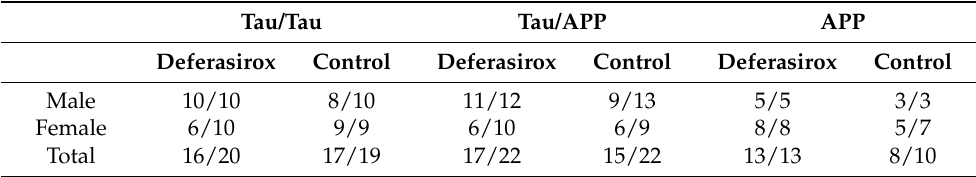
Table 1. Numbers of mice entering and completing the study. Denominators are the numbers of mice entering the study. Numerators are the numbers of mice completing the